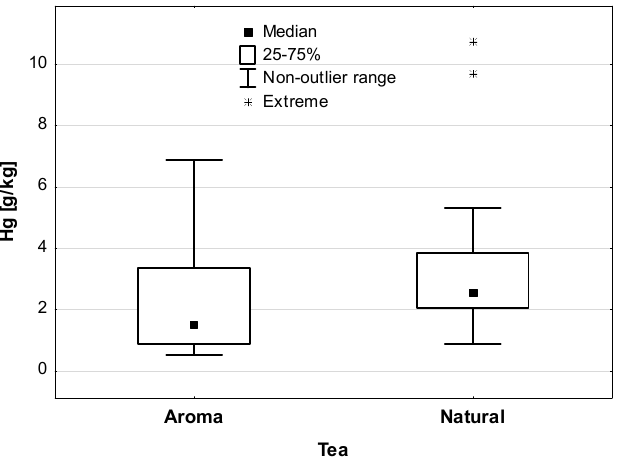
Figure 6. Hg concentration in tea with additives of natural origin and synthetic aroma, ( μ g/kg).